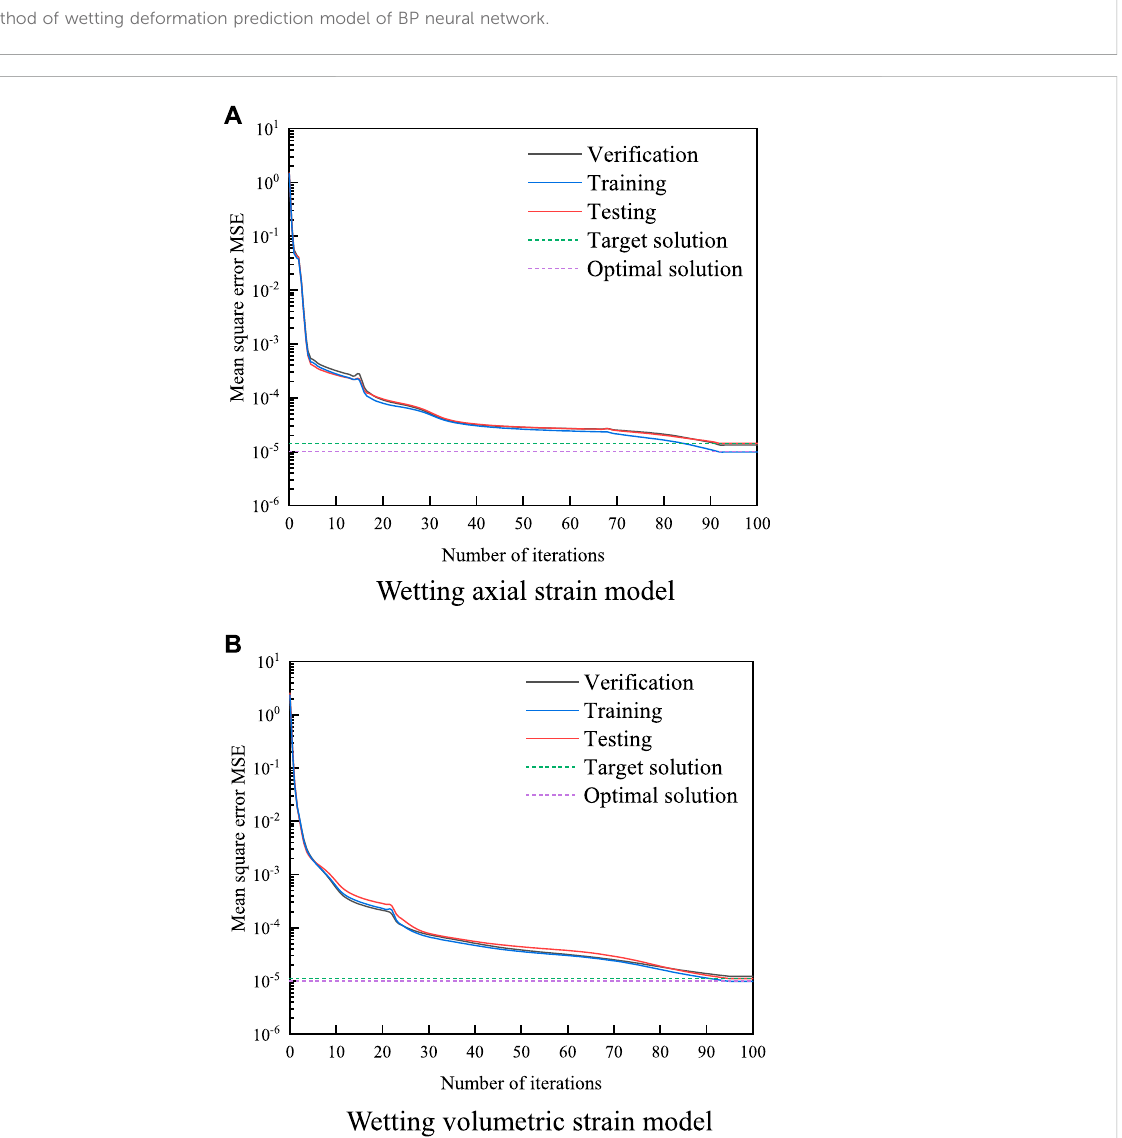
FIGURE 11 Iterative process of wetting prediction model. (A) Wetting axial strain model (B) Wetting volumetric strain model.